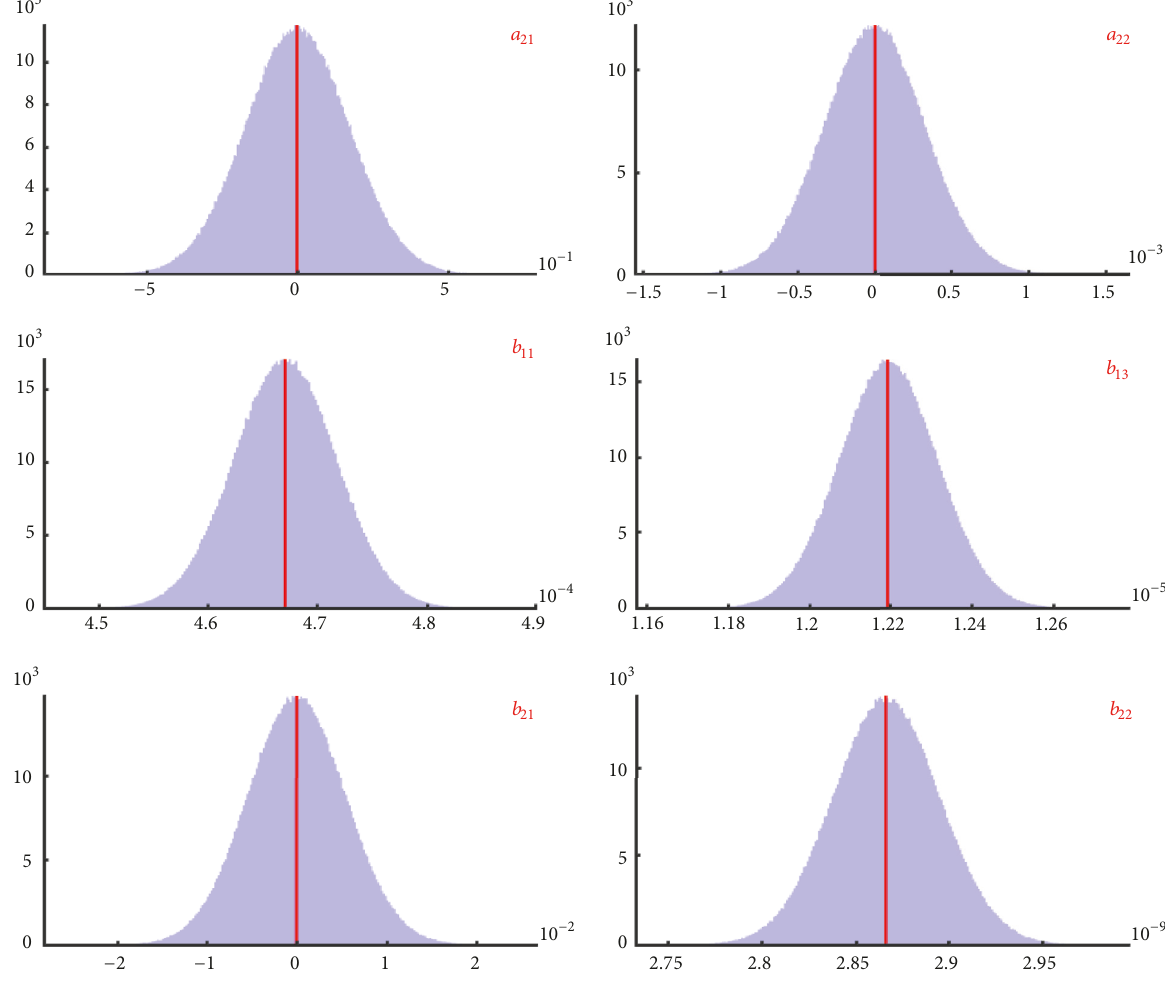
Figure 7: Histograms, ARX to SS transformation.